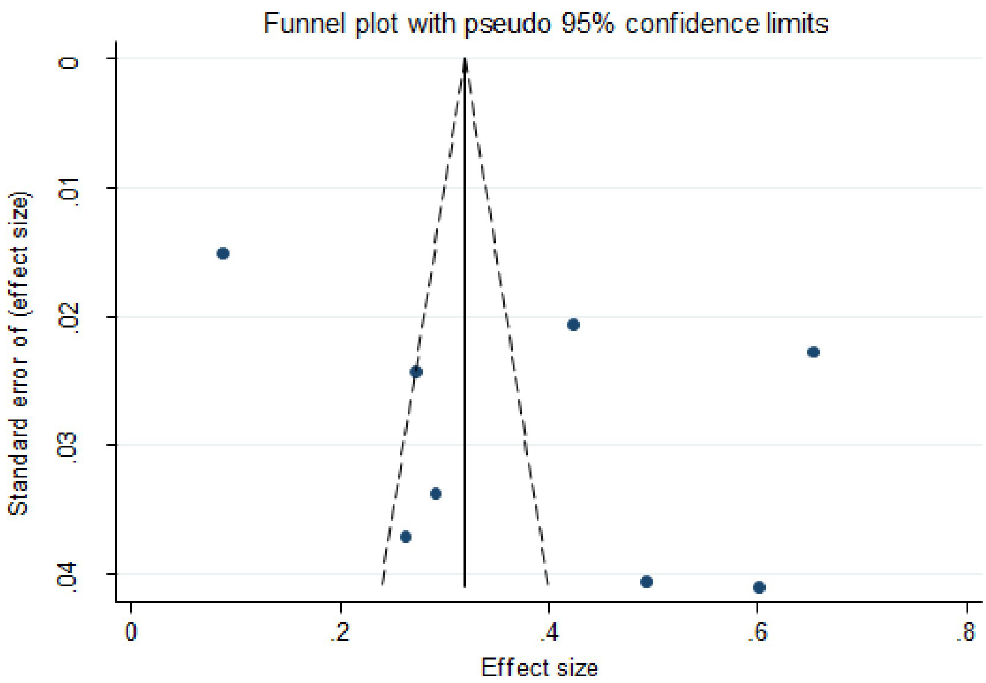
Fig 9. Funnel plot of a subgroup of 8 of the 20 selected studies for Xpert MTB/RIF assay positive EPTB.